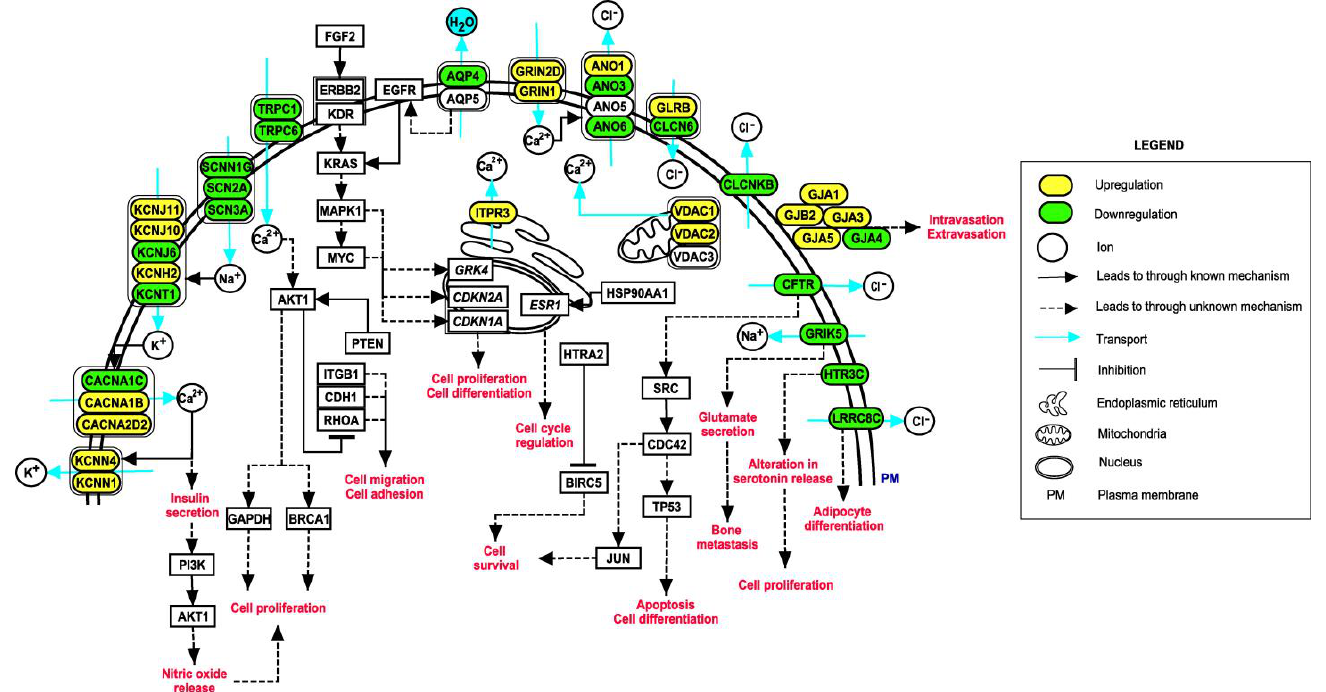
Figure 7. Depiction of events that may occur in breast cancer patients upon dysregulation of ion channels with EMT-related genes. The pathway map was generated using PathVisio (v3.3.0). Cancer phenotypes may appear due to alterations in important cellular processes, such as calcium signaling, insulin secretion, adipocyte metabolism, nitric oxide signaling and glutamatergic signaling.